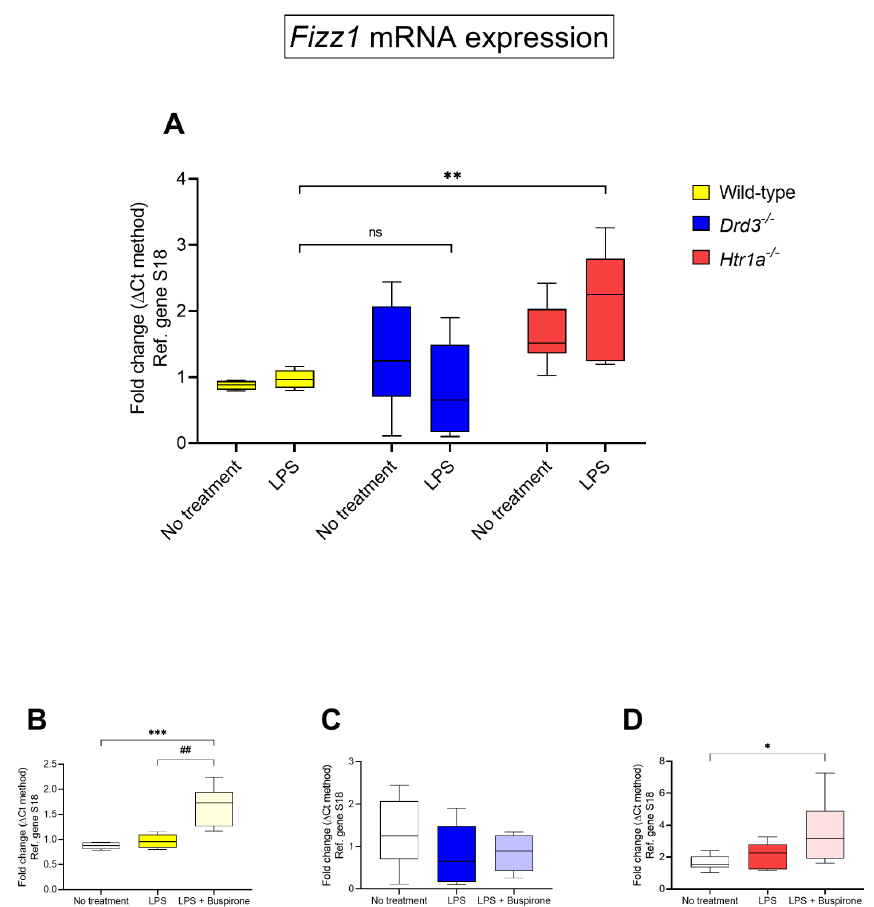
Figure 8. FIZZ1 mRNA expression following exposure to LPS and treatment with buspirone for 24 h. Gene expression was measured using real-time qPCR and quantified using the ∆∆ Ct method after normalization to the S18 housekeeping gene. ( A ) Box and whisker plots showing the differential expression of FIZZ1 transcripts in untreated or LPS-treated wild type, Drd3 −/− and Htr1a −/− cells or after co-treatment of ( B ) wild type, ( C ) Drd3 −/− and ( D ) Htr1a −/− cells with LPS in combi- nation with buspirone. Results are presented as mean fold changes with respect to no treatment ± SEM. Fold changes in each gene were obtained after normalisation to the endogenous reference gene. Baseline levels of no treatment groups were set to 1. * p < 0.05, ** p < 0.01 or *** p < 0.001 vs. no treatment or ## p < 0.01 vs. LPS, as determined by one-way or two- way ANOVA followed by Tukey or Dunnett’s post-hoc tests. Ns = not significant.